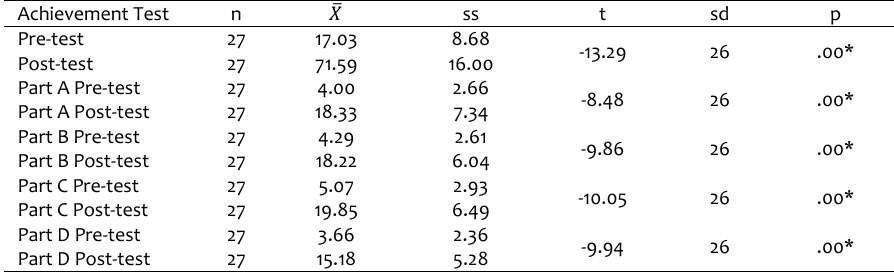
Table 7. The results of the Dependent Samples t-Test regarding the comparison of the pre-test and post-test mean scores of the Group Game Achievement Test n 𝑋̅